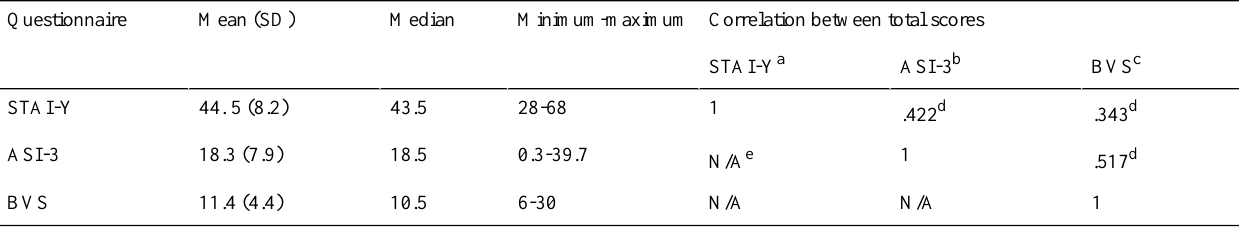
Table 2. Descriptive statistics of the total scores of the questionnaire